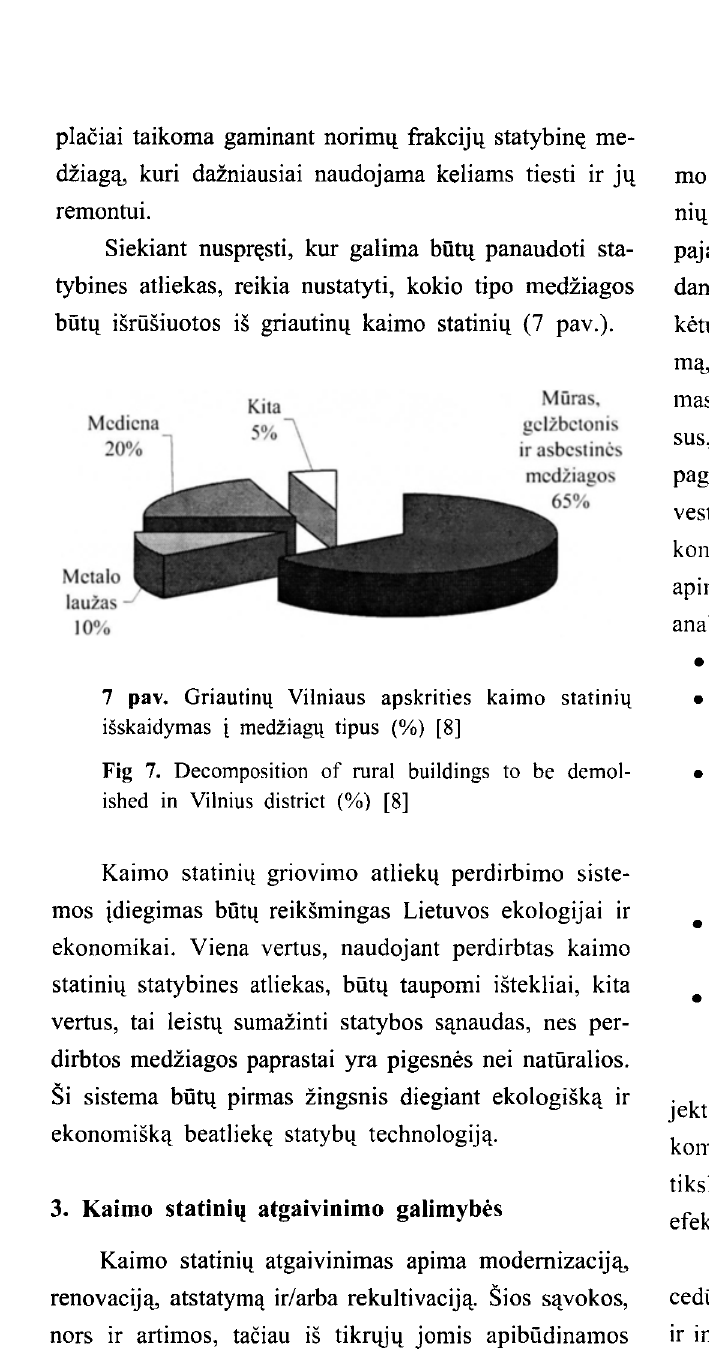
Fig 7. Decomposition of rural buildings to be demol ished in Vilnius district (%)